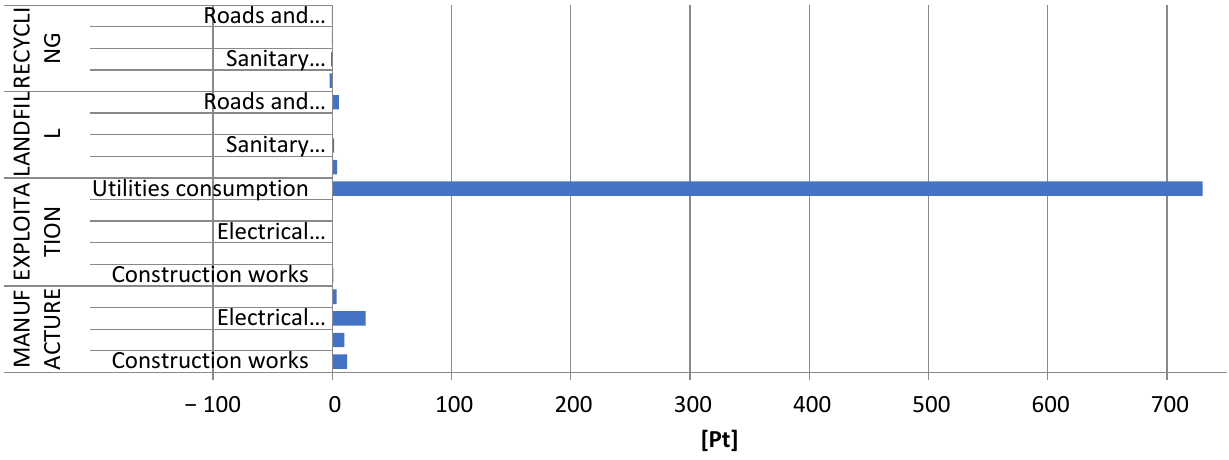
Figure 9. The results of grouping and weighing the environmental consequences occurring in the life cycle of the research object by the form of post-use development and the impact categories. Today, climate change is one of the key environmental problems around the world.